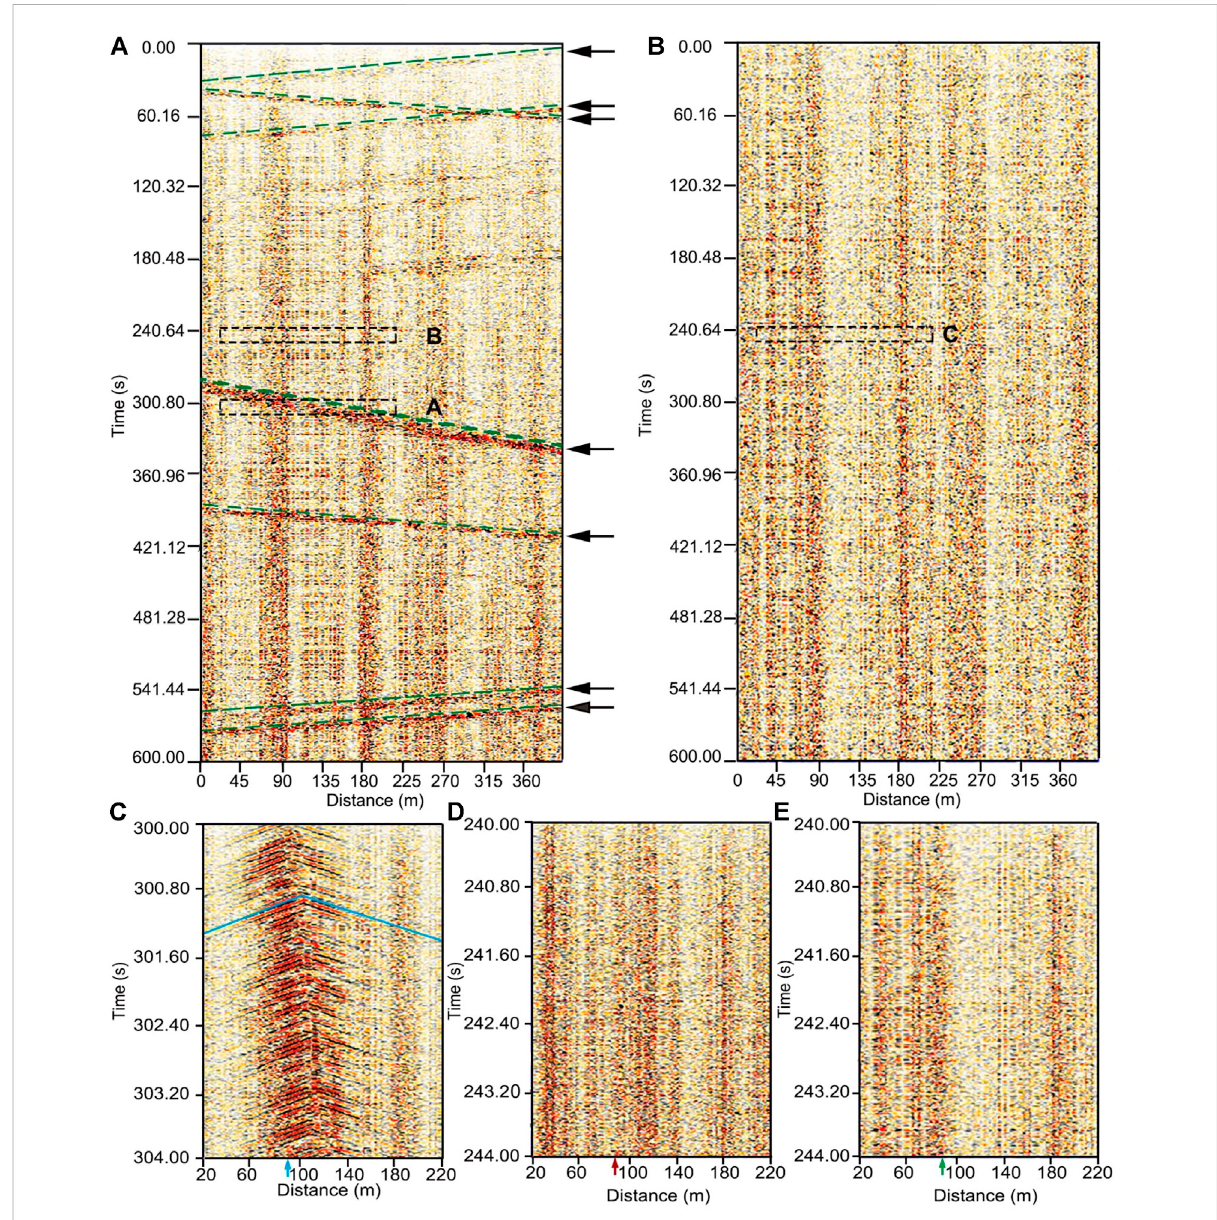
FIGURE 2 (A) Seismic data recorded by DAS line during 10 min of heavy road traf fi c. The black arrows indicate the vehicle-related seismic event and the green dashed lines indicate their slopes. (B) Seismic data recordedby DAS line during 10 min withoutroad traf fi c. (C – E) The zoomed-in view of data indicated by the rectangles labeled A-B in (A) and labeled C in (B) . The color arrows indicate the locations of seismic waveforms and amplitude spectra in Panel 3. The blue lines in (C) represent the propagation velocity of wave fi eld excited by the